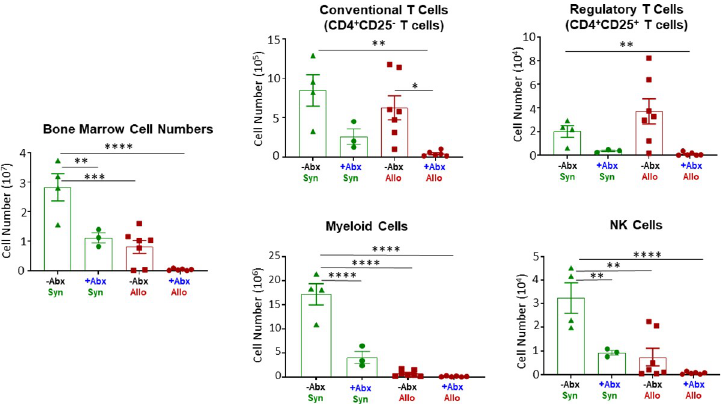
Fig 2. Acute GVHD-induced bone marrow damage. Total bone marrow (BM) cell numbers as well as BM-residing immune cells were quantified at 4 weeks post T cell transfer for mice in the 4 groups described in Fig 1. Conventional (CD4 + CD25 - ) T cells, regulatory T cells (Tregs; CD4 + CD25 + ), myeloid (CD11b + ) cells and NK (CD335 + ) cells were quantified by flow cytometry. Asterisks ( � ) designate significant differences between groups. ( � p < 0.05, �� p < 0.01, ��� p < 0.001, ���� p < 0.0001).